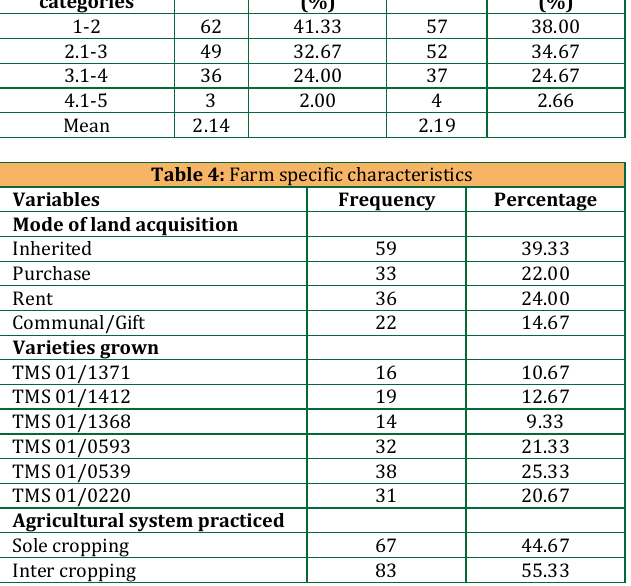
Table 3: Farm size of bio-fortified cassava farms Farm size (ha)